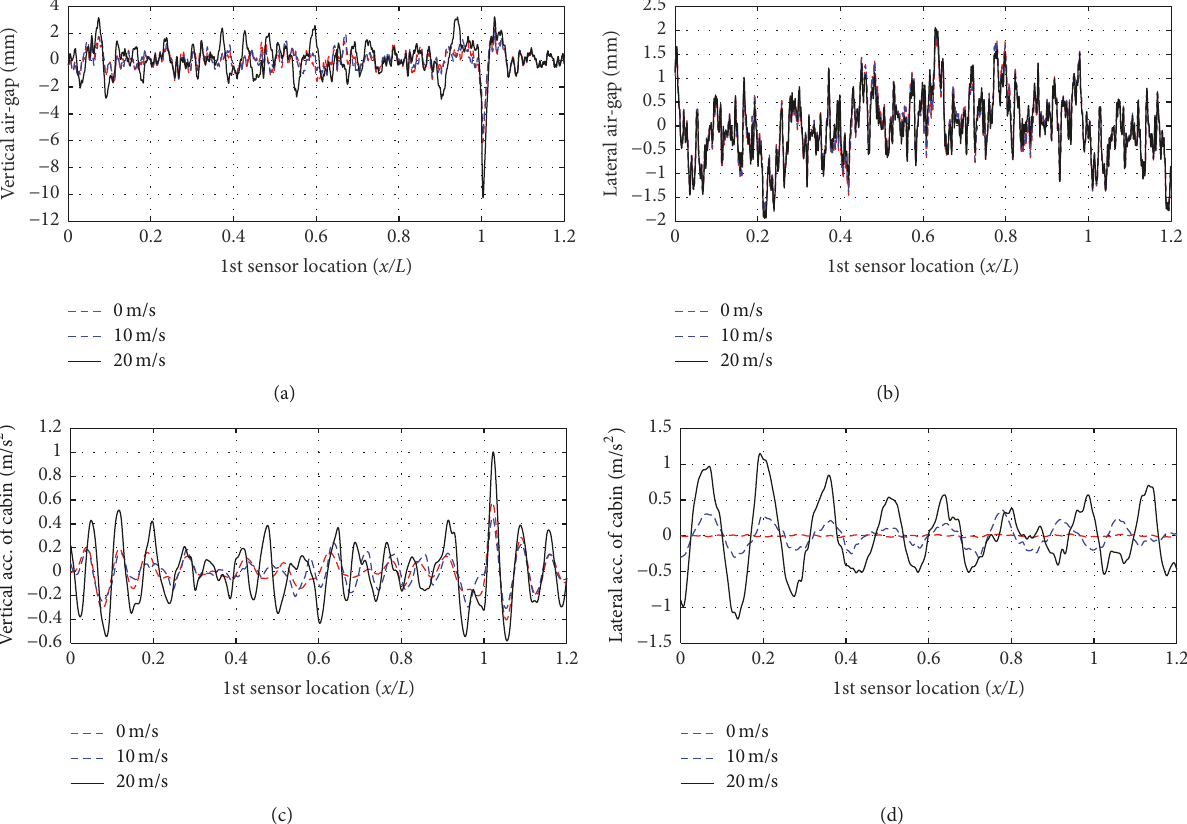
Figure 20: Time history responses of maglev vehicle under various wind speed (vehicle speed: 100km/h): (a) vertical air-gap at 1st sensor, (b) lateral air-gap at 1st sensor, (c) vertical acceleration of cabin, and (d) lateral acceleration of cabin.